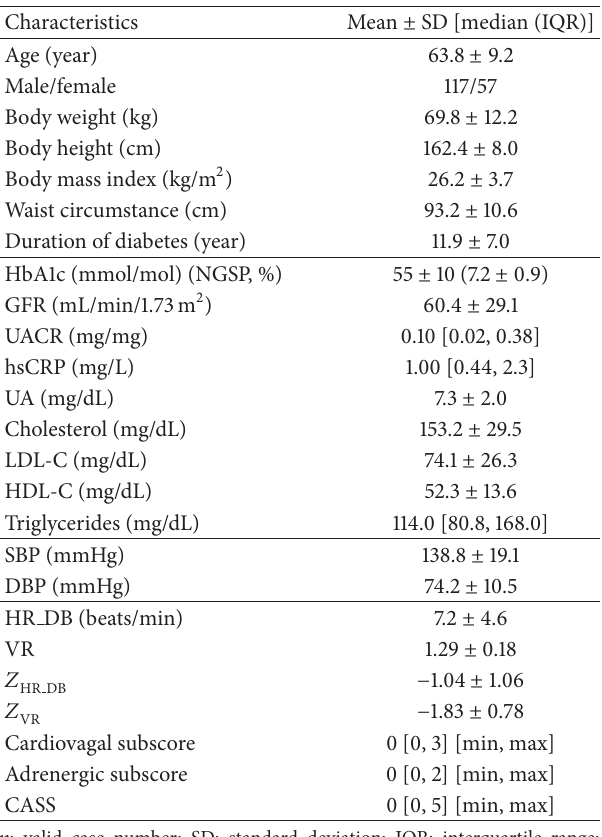
Table 2: Characteristics and biochemical data of patients with type 2